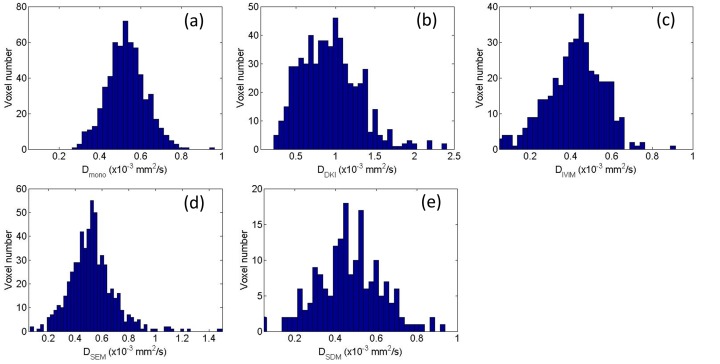
The histograms of the extracted voxel-wise diffusion coefficients based on the mono-exponential model (a), diffusion kurtosis model (b), intravoxel incoherent motion (c), stretched exponential model (d) and statistical diffusion model (e) from each model, i.e. Dmono, DDKI, DIVIM, DSEM and DSDM, within the ROIs of the metastatic node in Fig. 4.Note that the fitted values around zero for the statistical model were excluded in (e) for better visualization.